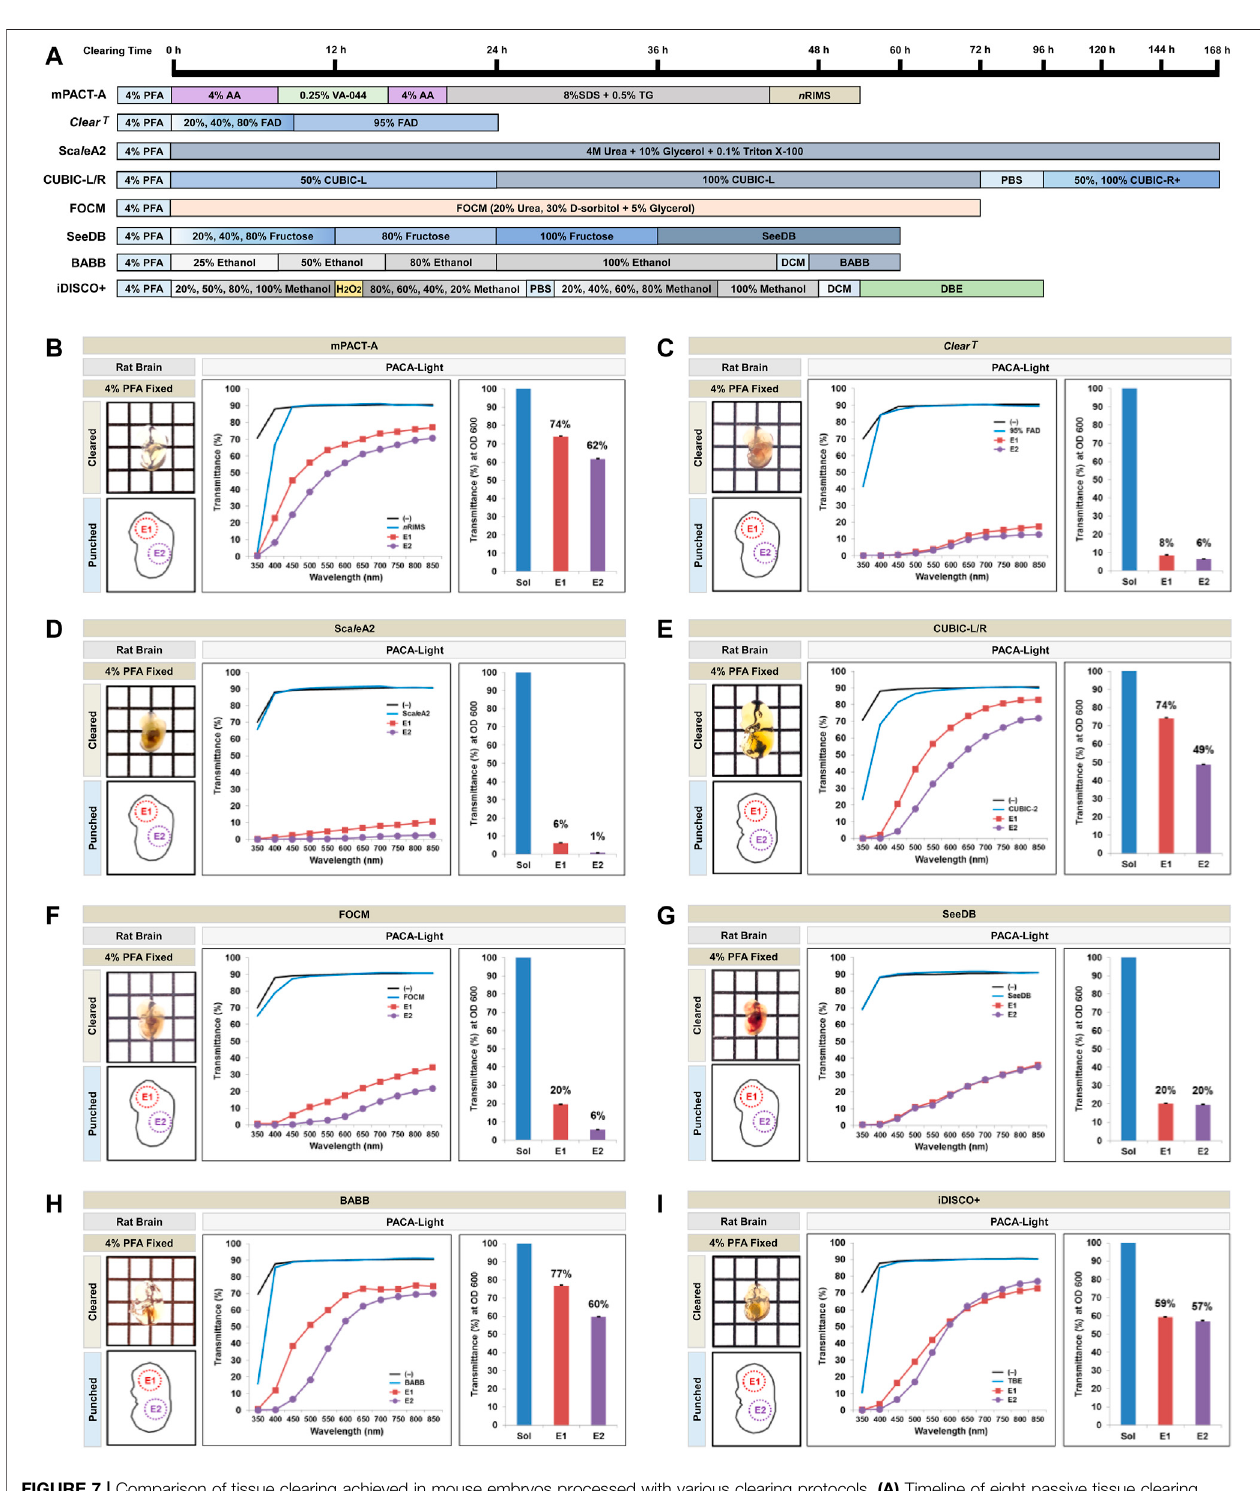
FIGURE 7 | Comparison of tissue clearing achieved in mouse embryos processed with various clearing protocols. (A) Timeline of eight passive tissue clearing methods in mouse embryo. The individual reagents or processes used for dehydration and clearingprocess in the clearingmethods are shown. Comparison of clearing ef fi cacies of mPACT-A (B) , Clear T (C) , Sca l eA2 (D) , CUBIC-L/R (E) , FOCM (F) , SeeDB (G) , Ethanol BABB (H) , and iDISCO+ (I) , on E12.5 or E13.5 embryos and determined by PACA-Light. Optical images show samples after clearing. Two discs from two distinct embryo regions [E1: head (square, red), E2: body (diamond, violet)]weregeneratedandanalyzedforeachsample.Eachcolorlineandbarpointtoassessmentvaluesofempty(black)andrefractiveindexmatchingsolution(blue)of each protocol. The results represent three replicates of each experiment, and data are presented as the mean ± SD (standard deviation).